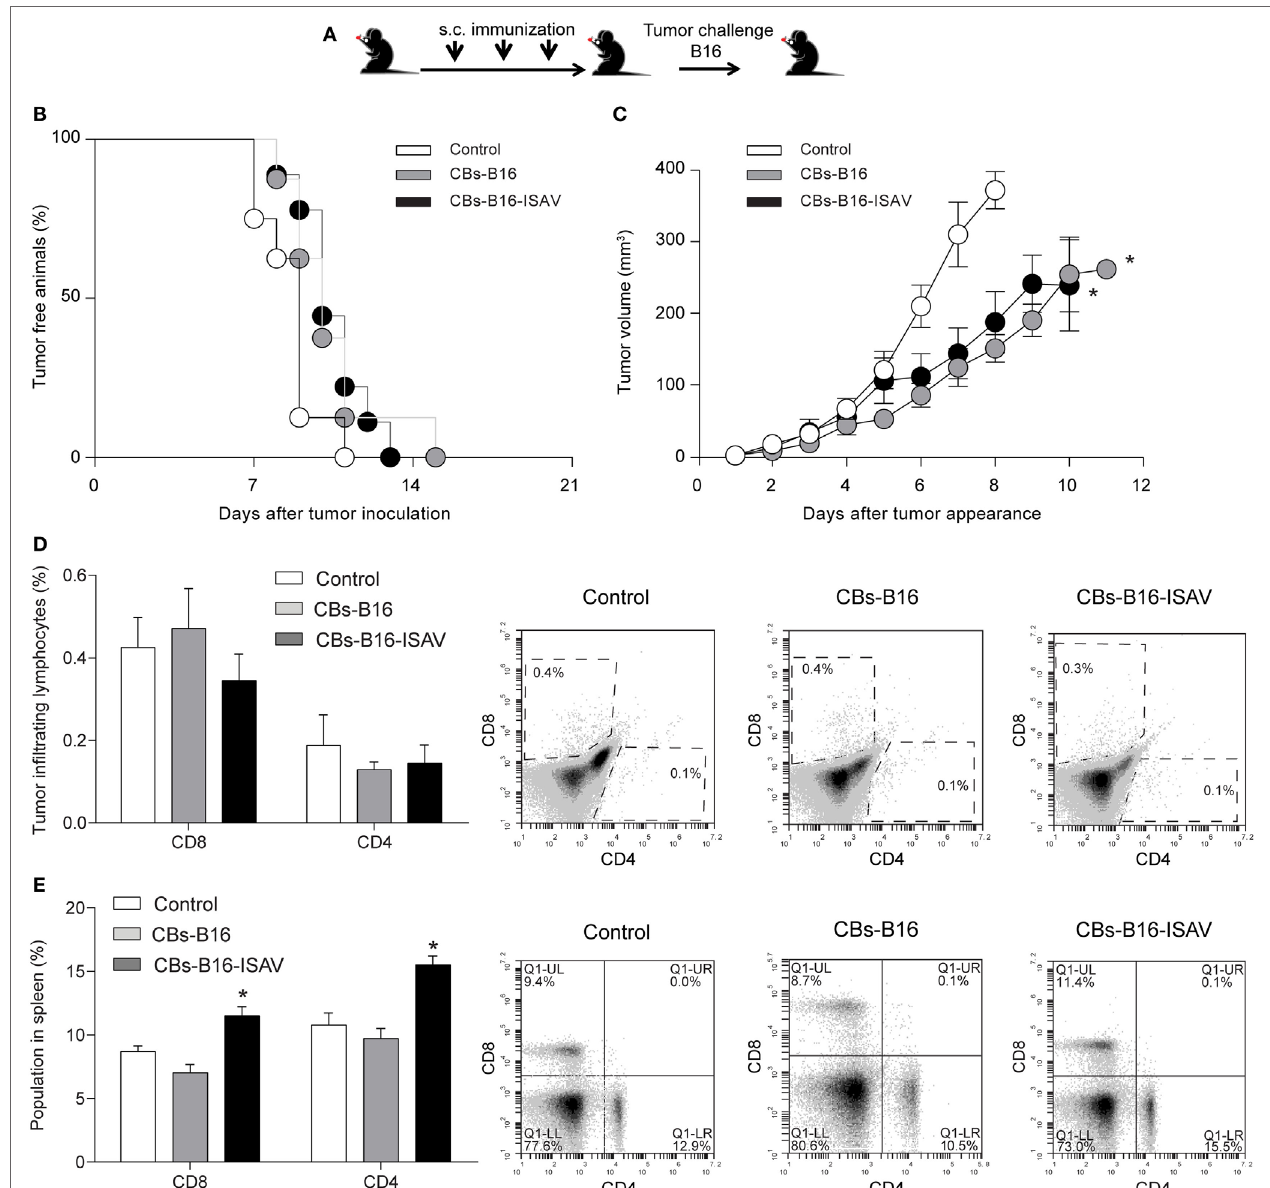
FigUre 6 | Effect of immunization with B16 and B16-ISAV cell bodies in C57BL/6 mice challenged with B16 tumor cells. (a) Schematic representation of the immunization protocol. C57BL/6 mice were immunized every 7 days at 3-week intervals with 100 µL of cellular bodies (from 1 × 10 5 cells) generated from non-transfected or infectious salmon anemia virus (ISAV)-transfected B16 cells. One week after the final immunization, the animals were challenged with 2 × 10 5 viable B16. (B) Tumor free animals. (c) Tumor growth after tumor appearance in C57BL/6 mice. (D) CD8 and CD4 tumor infiltrating lymphocytes. (e) CD8 and CD4 spleen lymphocytes. Statistical analyses were performed using Kruskal–Wallis ANOVA ( n = 7; * p <